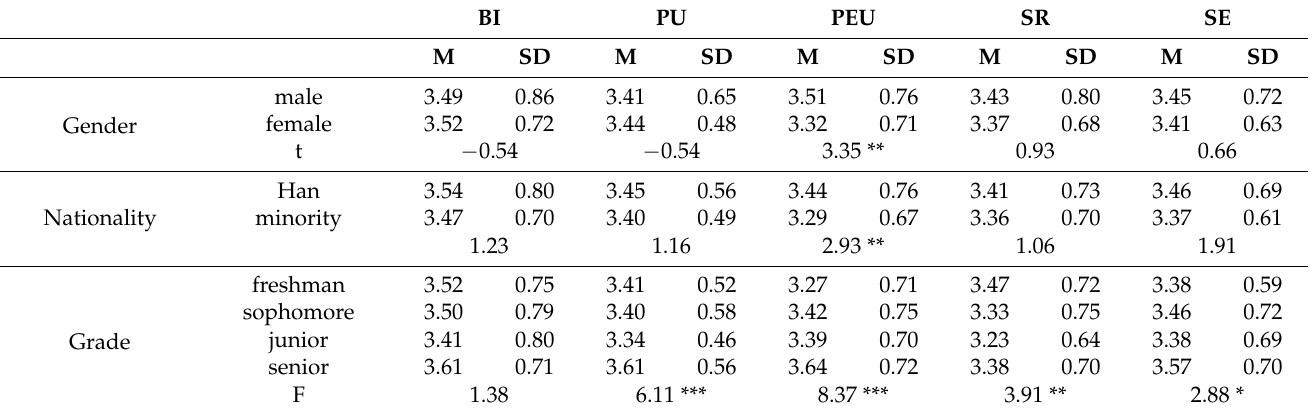
Table 4. Differences test BI, PU, PEU, SR and SE by gender, nationality and grade. BI PU